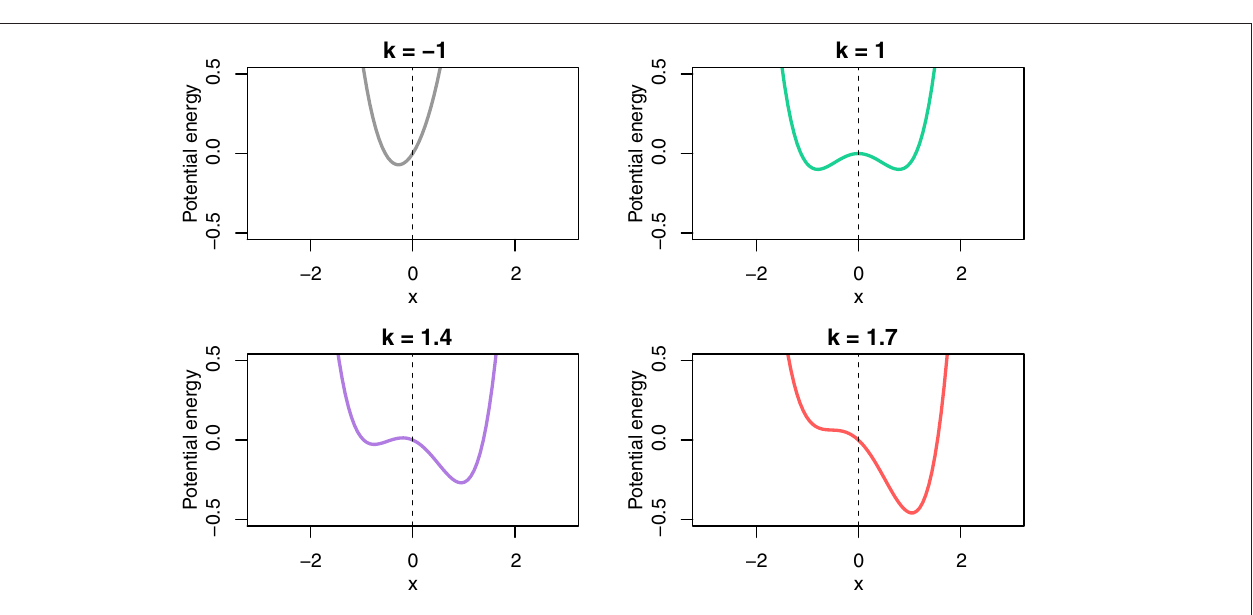
FIGURE 9 | Development of the attractor landscape for V(x) of Equation 5 with different control parameter